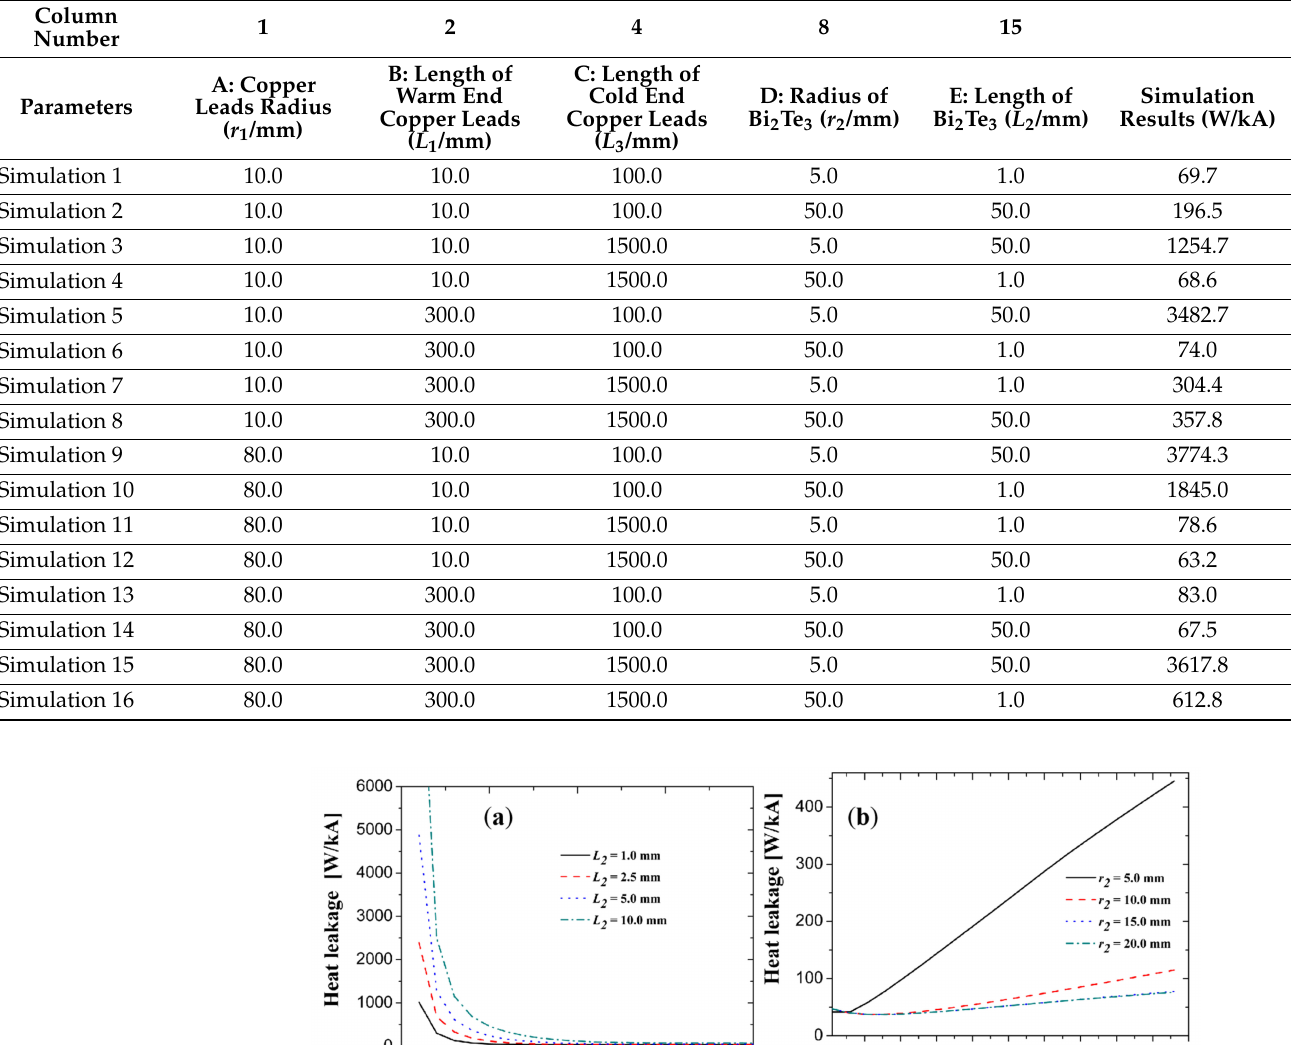
Table A2. Orthogonal experimental schedule for 1200 A PCLs.